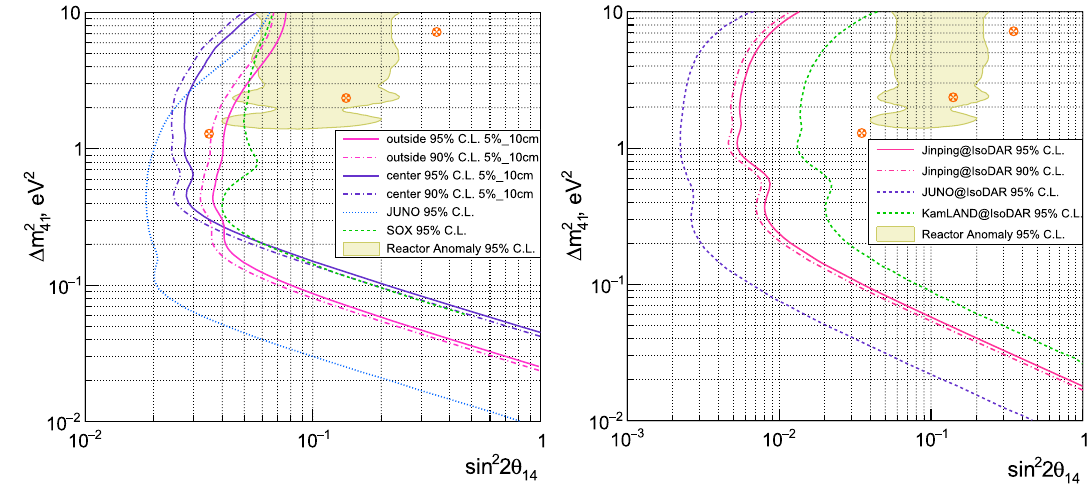
Fig. 4 The exclusion contours on a two-dimensional parameter space. 90% and 95% C.L. are shown for two possible setups. The left panel corresponds to the radioactive source and the right part corresponds to the IsoDAR. Combined reactor anomaly is also shown [7]. The stars